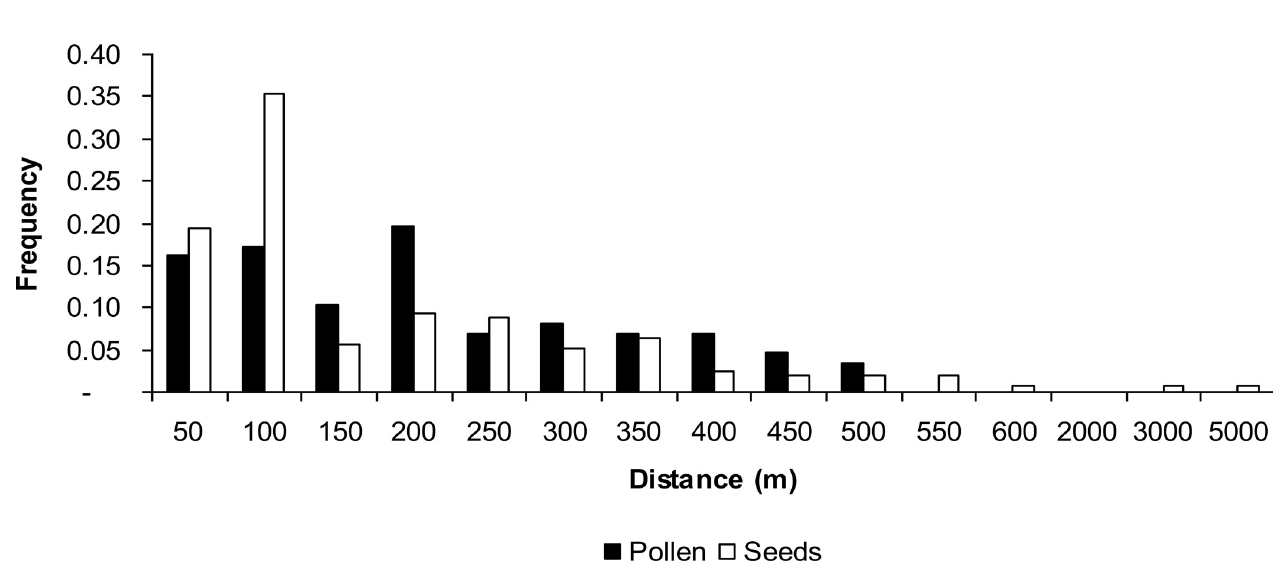
Fig 5. Pollen and seed dispersal distance for Astronium fraxinifolium individuals in the Regenerant Population (RP).